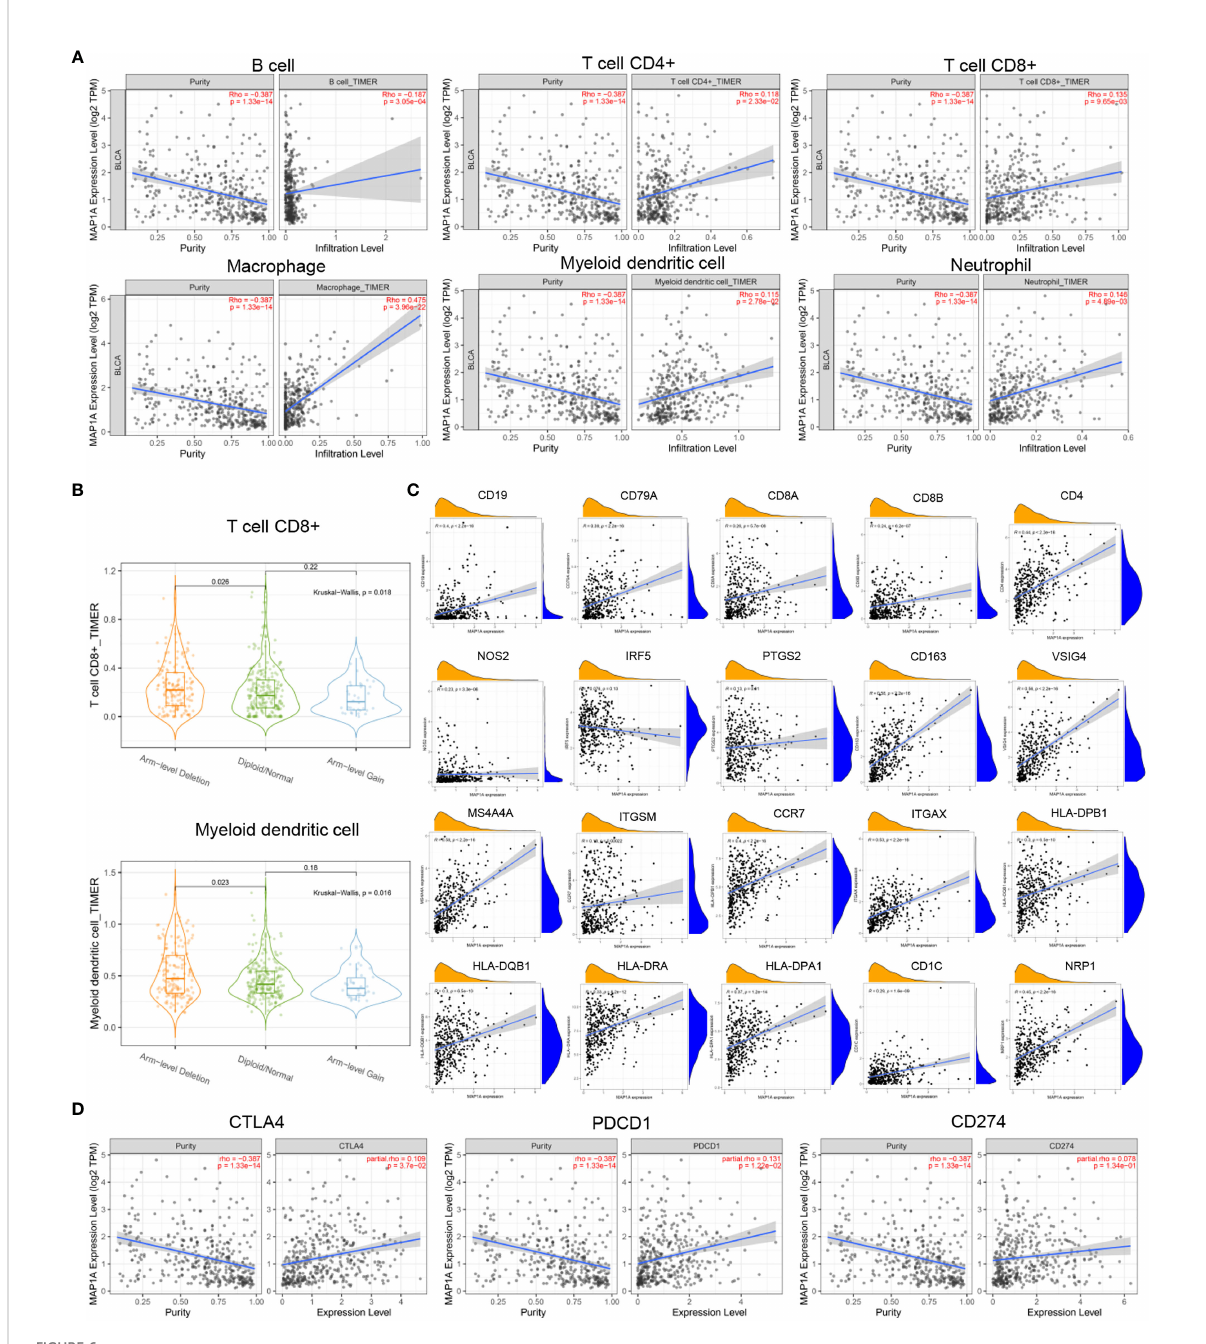
FIGURE 6 Correlation between MAP1A and immune cells, immune cell genes, and immune checkpoints. (A) Visual analysis of the correlation between MAP1A gene expression and the content of immune cells (B cells, T cells, macrophages, DCs, neutrophils). (B) Correlation between MAP1A gene copy number and immune cells CD8 + T cells, mDCs. (C) Correlation between B cell genes (CD19, CD79A), CD8 + T cell genes (CD8A, CD8B), CD4 + T cell genes (CD4), M1 macrophage genes (NOS2, IRF5, PTGS2), M2 macrophage genes (CD163, VSIG4, MS4A4A), neutrophil genes (ITGAM, CCR7), DC genes (HLA-DPB1, HLA-DQB1, HLA-DRA, HLA-DPA1, CD1C, NRP1, ITGAX), and other immune cell genes expression and MAP1A gene expression were visualized in the correlation analysis. (D) A visual analysis of the relationship between the expression of immune checkpoint genes CD274, PDCD1, CTLA4, and